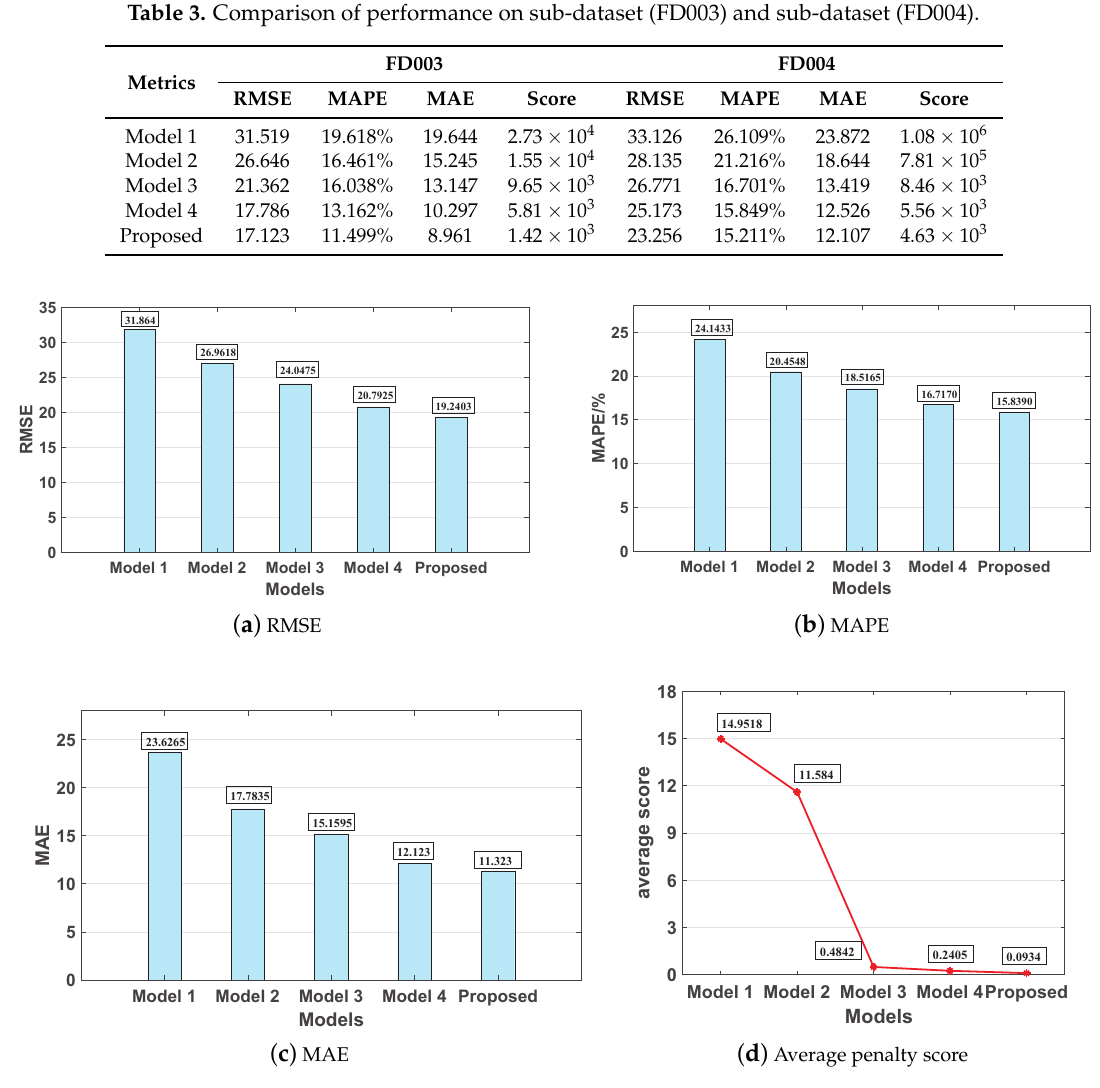
Figure 10. Model